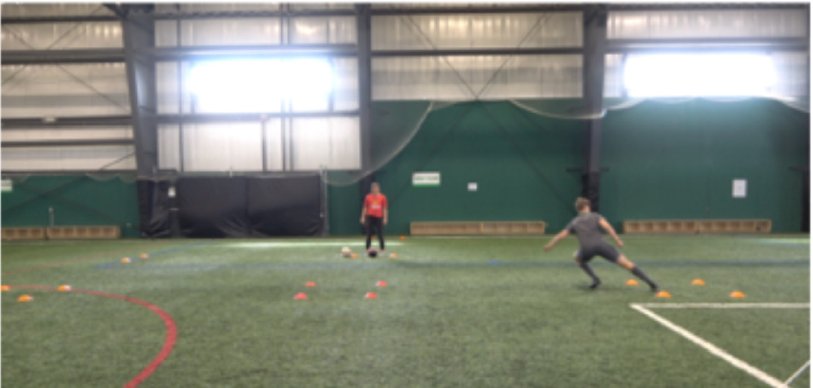
Figure 1. Change of direction test: player making a left turning 180° pivot turn (PFC—left leg, FFC—right leg).